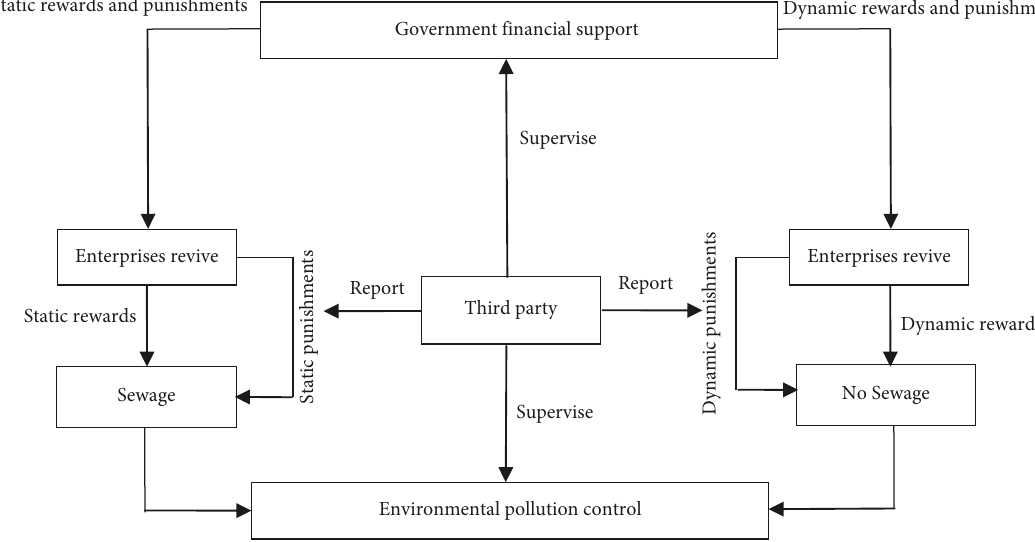
Figure 1: The economic revitalization mechanism of government supported